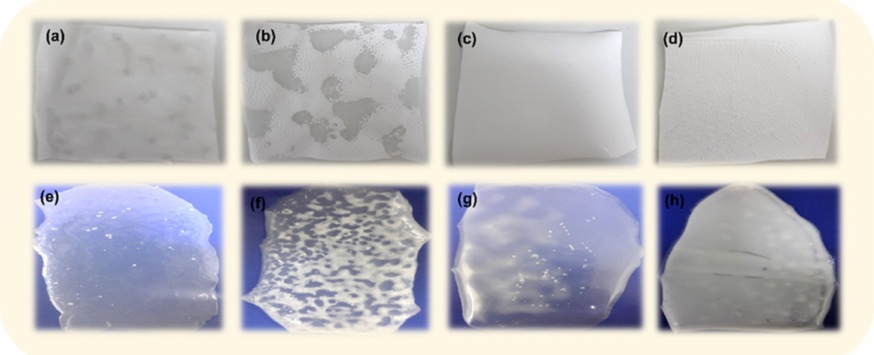
Figure 3. The effect of the additive addition in PETU-based solution before membrane preparation in wet solution casting: ( a ) without additive, ( b ) with 1%, ( c ) 2%, and ( d ) 5% of L-31; and in dry solution casting: ( e ) without additive, ( f ) with 1%, ( g ) 2%, and ( h ) 5% of